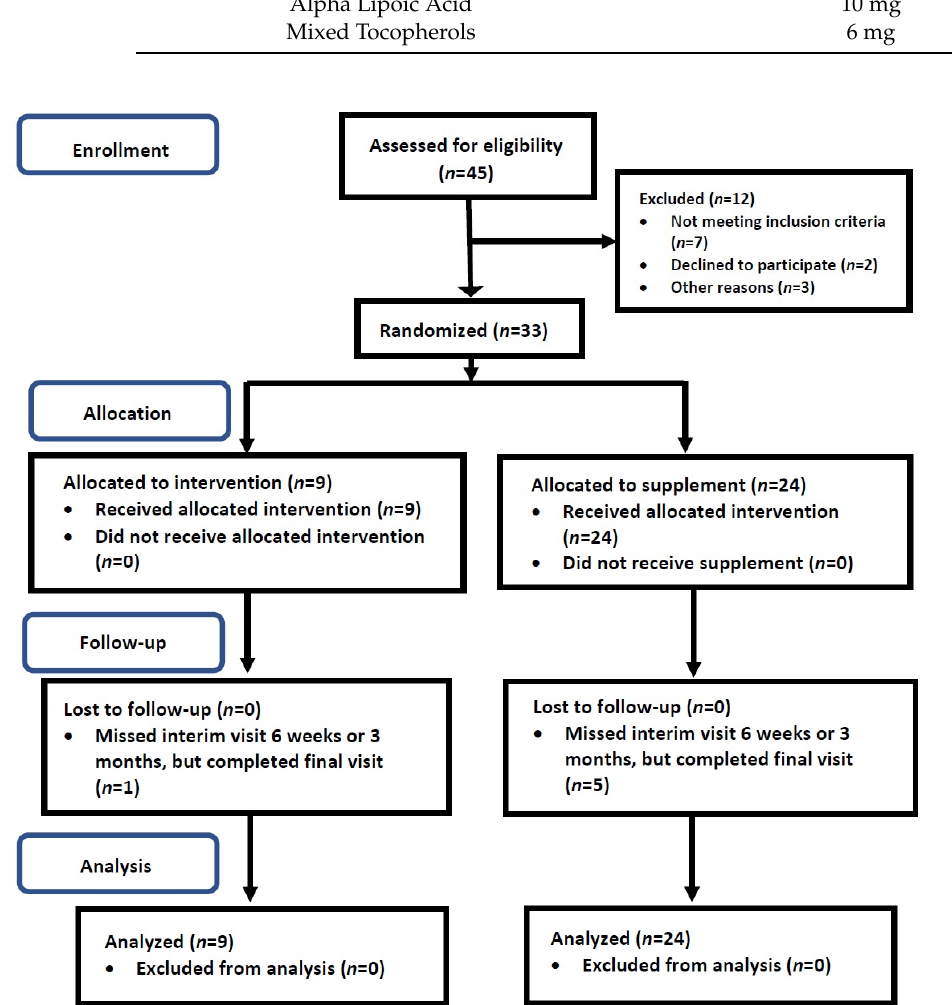
Figure A1. Consort Flow Diagram Explaining the Enrollment, Allocation, Follow-Up and Final Subjects Included in The